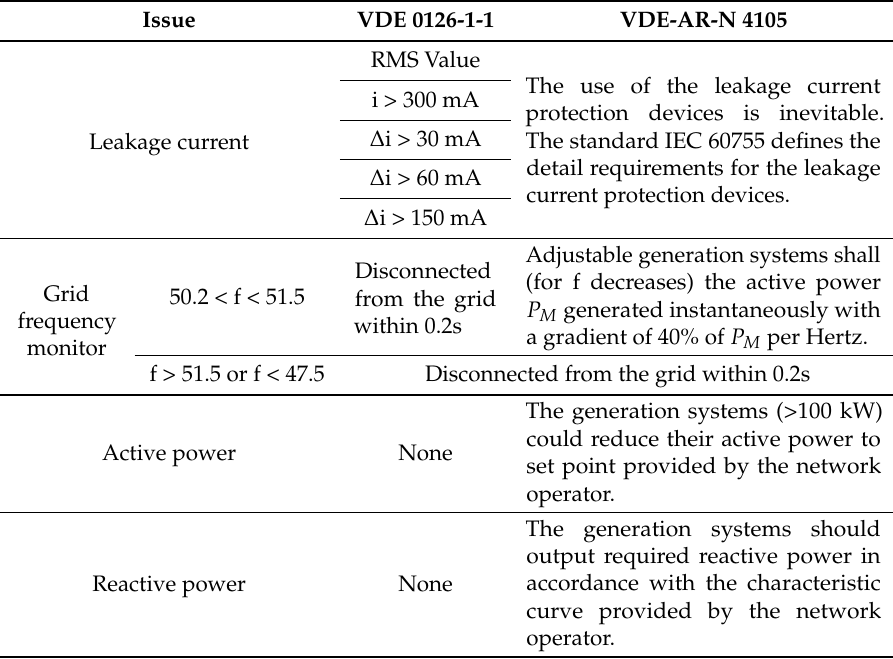
Table 1. German Code VDE Comparison